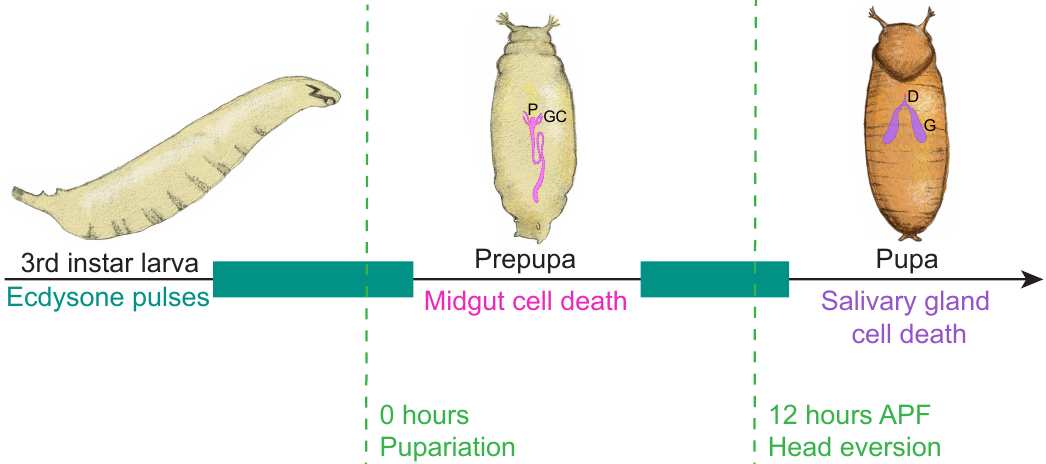
Figure 6. Ecdysone-induced cell death in larval tissues during Drosophila metamorphosis. A schematic depicting pulses of ecdysone (teal) during the developmental progression from larva to pupa. The first pulse of ecdysone in late third instar larvae triggers midgut histolysis (pink), including the proventriculus (P) and gastric caeca (GC). The second pulse of ecdysone, ~10 h after puparium formation (APF), leads to salivary gland degradation (purple), including the duct (D) and gland (G) tissues. Figure adapted from Baehrecke [132]. The midgut at 0 h in Jiang et al. was used as a reference for the anterior midgut region in this schematic [145]. Organ location and size